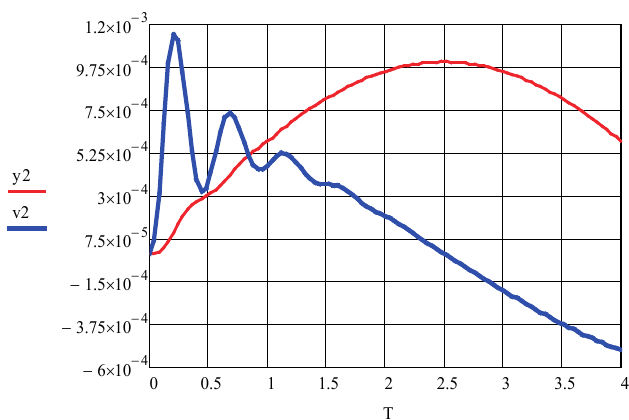
Fig. 6. Amplitude and speed of displacement of the unsprung weight at V = 2.5 m/sec, A = 0.005 mm.